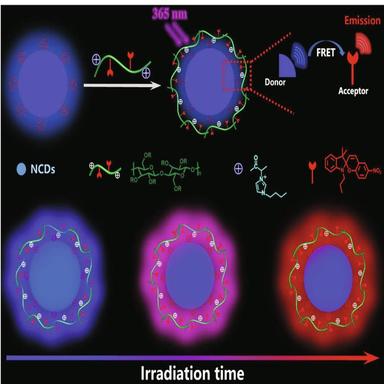
Schematic of design principle and mechanism of CDs-based dynamic optical materials.